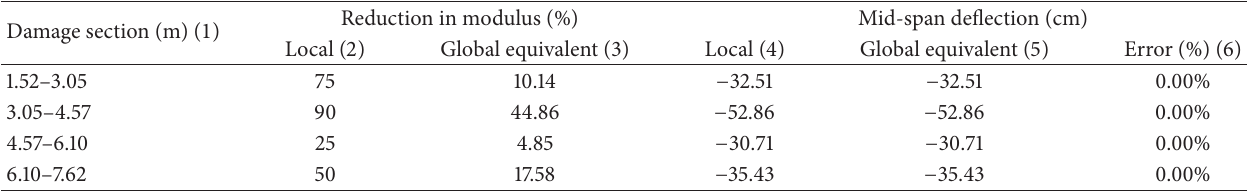
∗ Number in [] indicates percent reduction in equivalent modulus for local damage cases. Table 2: Validation of equivalent modulus